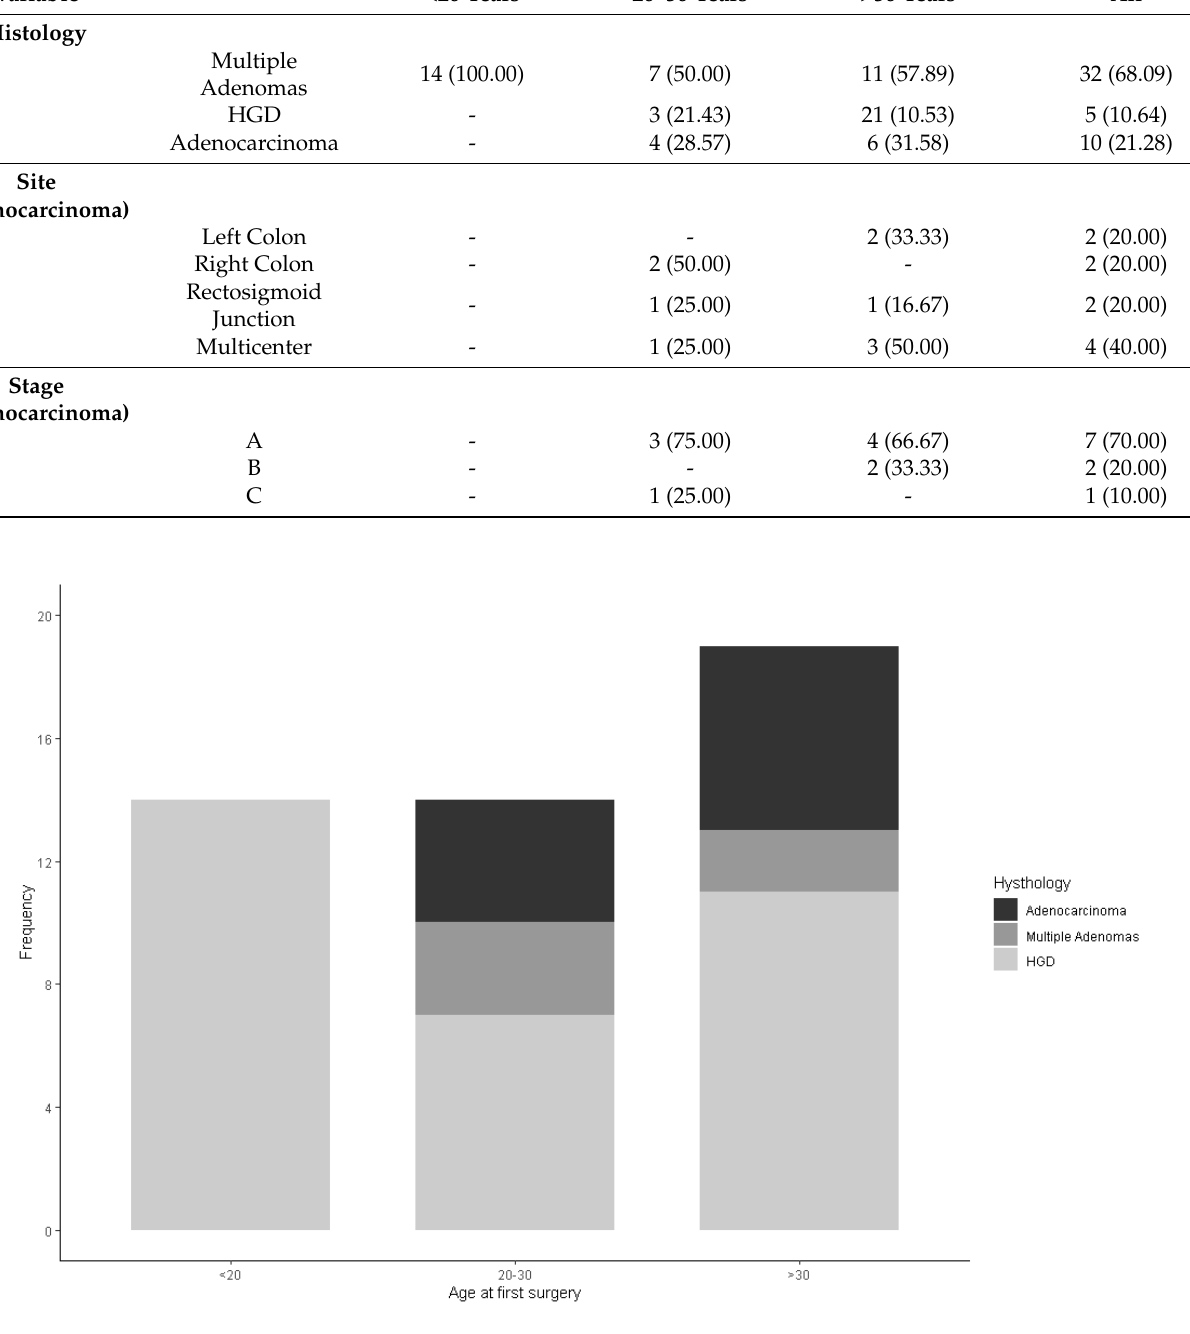
Figure 2. Bar charts representing the distribution of the baseline histology according to the three age classes. On the x ‐ axis are reported the three age classes and on the y ‐ axis the number of subjects according to baseline histology.